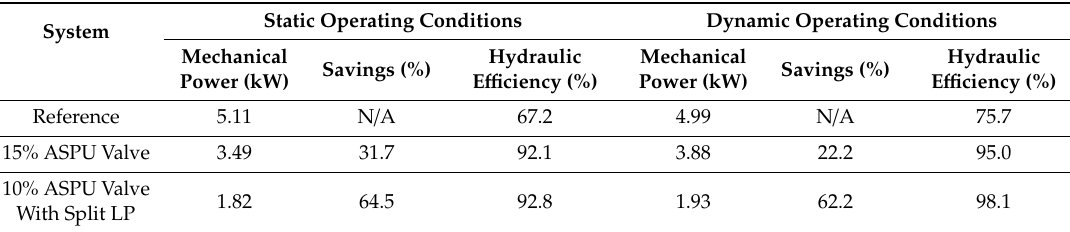
Table 6. Summary of power consumption and